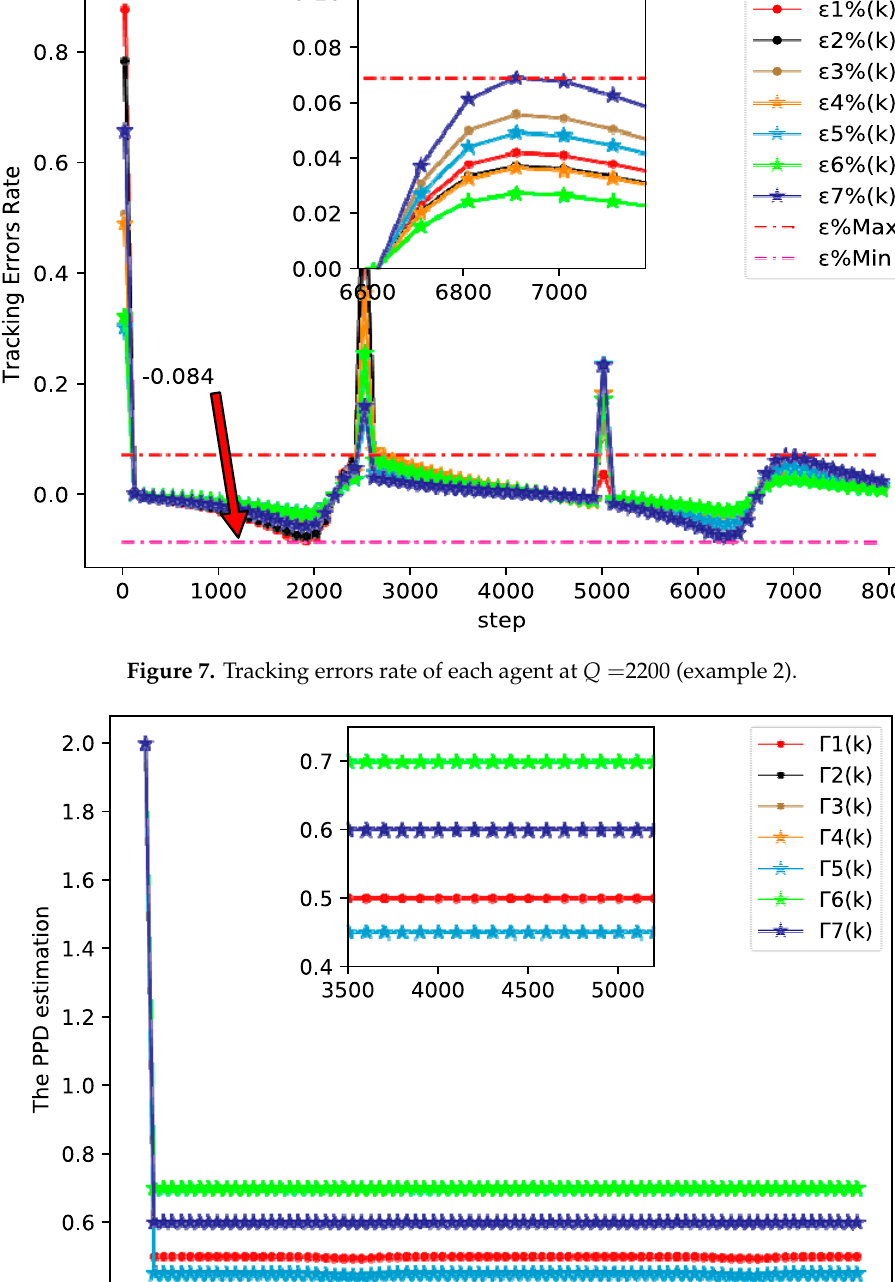
Figure 8. PPD estimation of each agent (example 2).